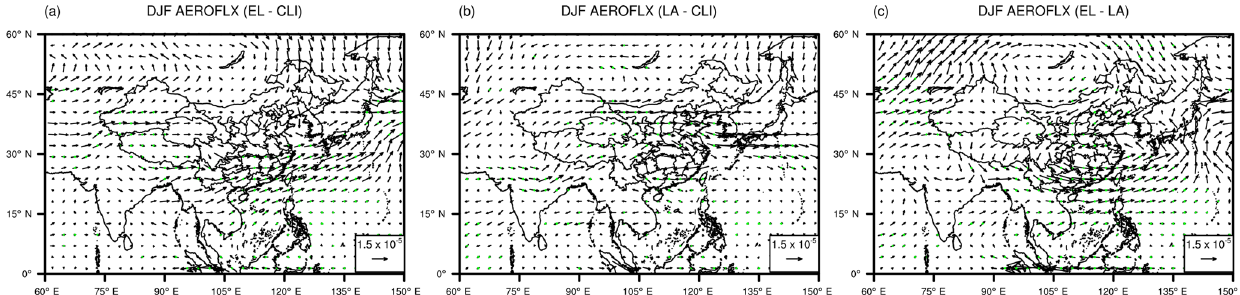
Figure 12. Medians of the simulated differences in the winter-average vertical integral of aerosol horizontal fluxes (AEROFLX; units: kgm − 1 s − 1 ) between (a) EL and CLI, (b) LA and CLI, and (c) EL and LA, with green dots indicating that the differences of the zonal components of AEROFLX between more than 70% of ensemble member pairs have the same sign as the median